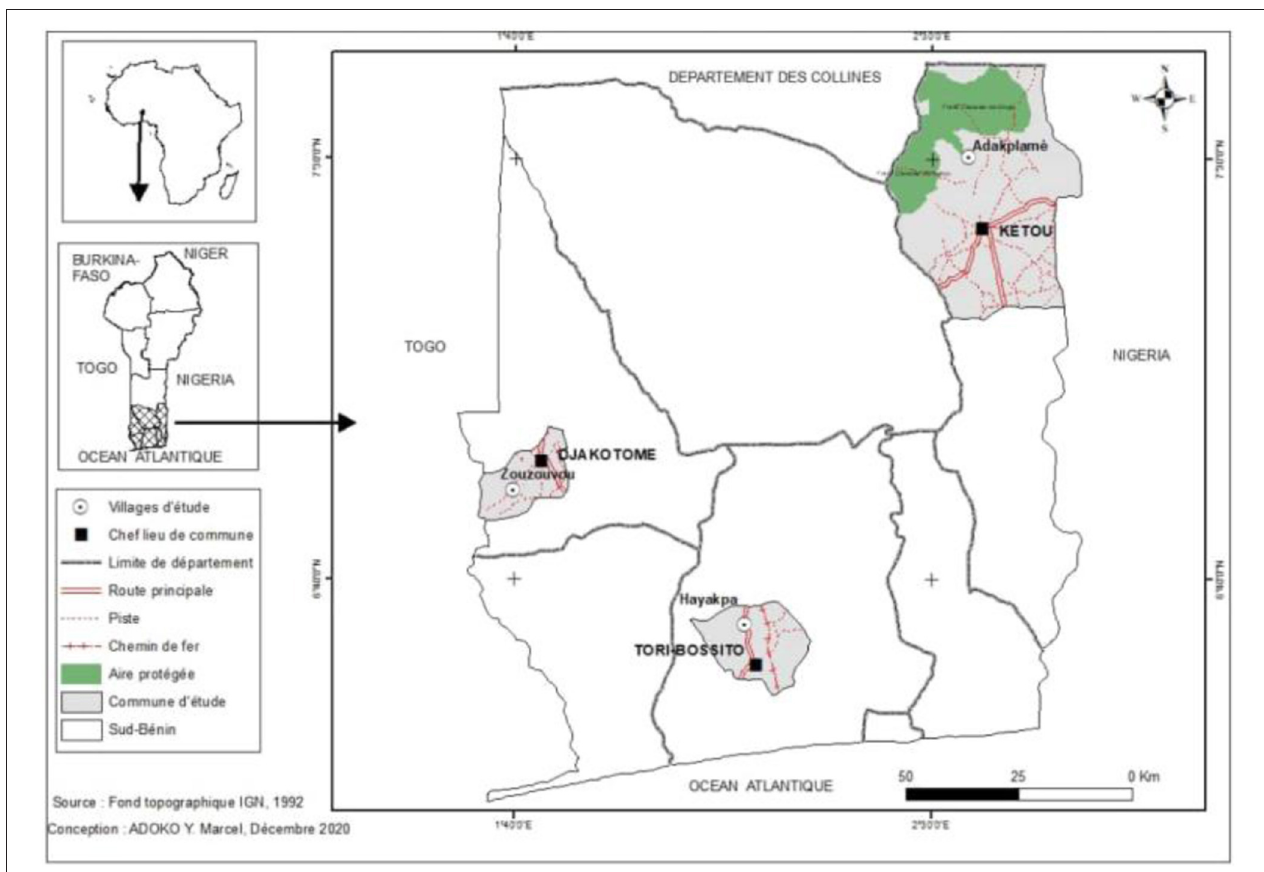
FIGURE 1 | Map showing the different study